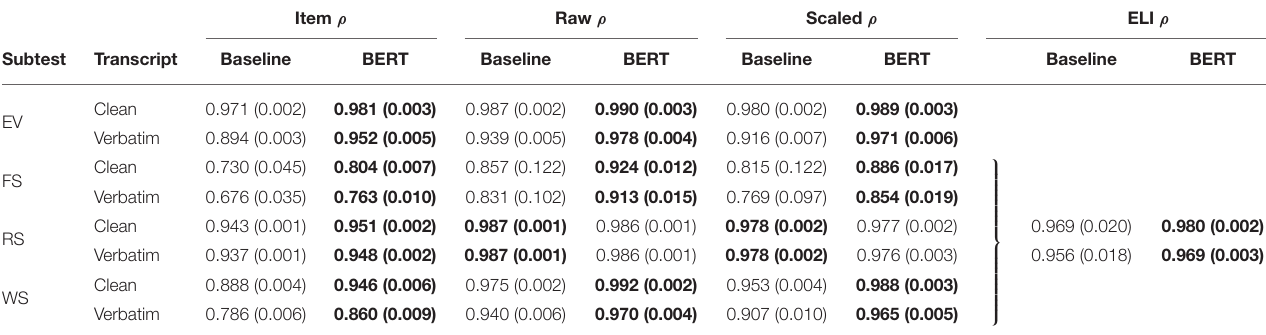
TABLE 6 | Average Spearman’s correlation results over 20 repeats (with standard deviations) for Item, Raw, and Scaled Score estimation.